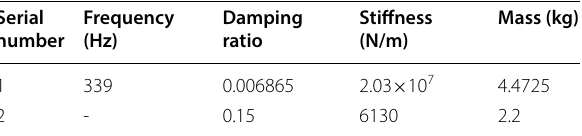
Table 1 Dynamic parameters of the experimental system